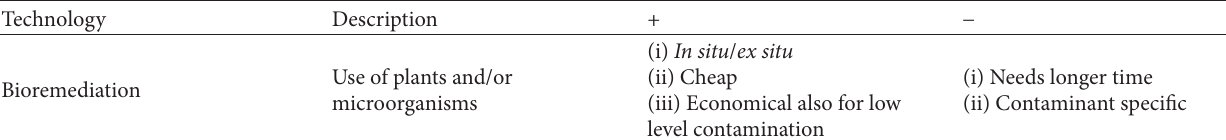
Table 1: Comparison of technologies used for decontamination of polluted areas